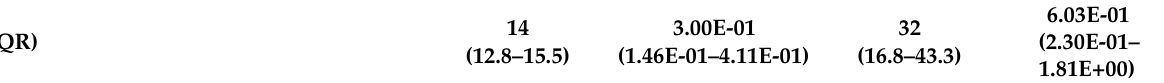
Table 6. Effective half-life (T e ) and dosimetry estimate of tumor lesions with [ 177 Lu]Lu-DOTAGA.(SA.FAPi) 2 .